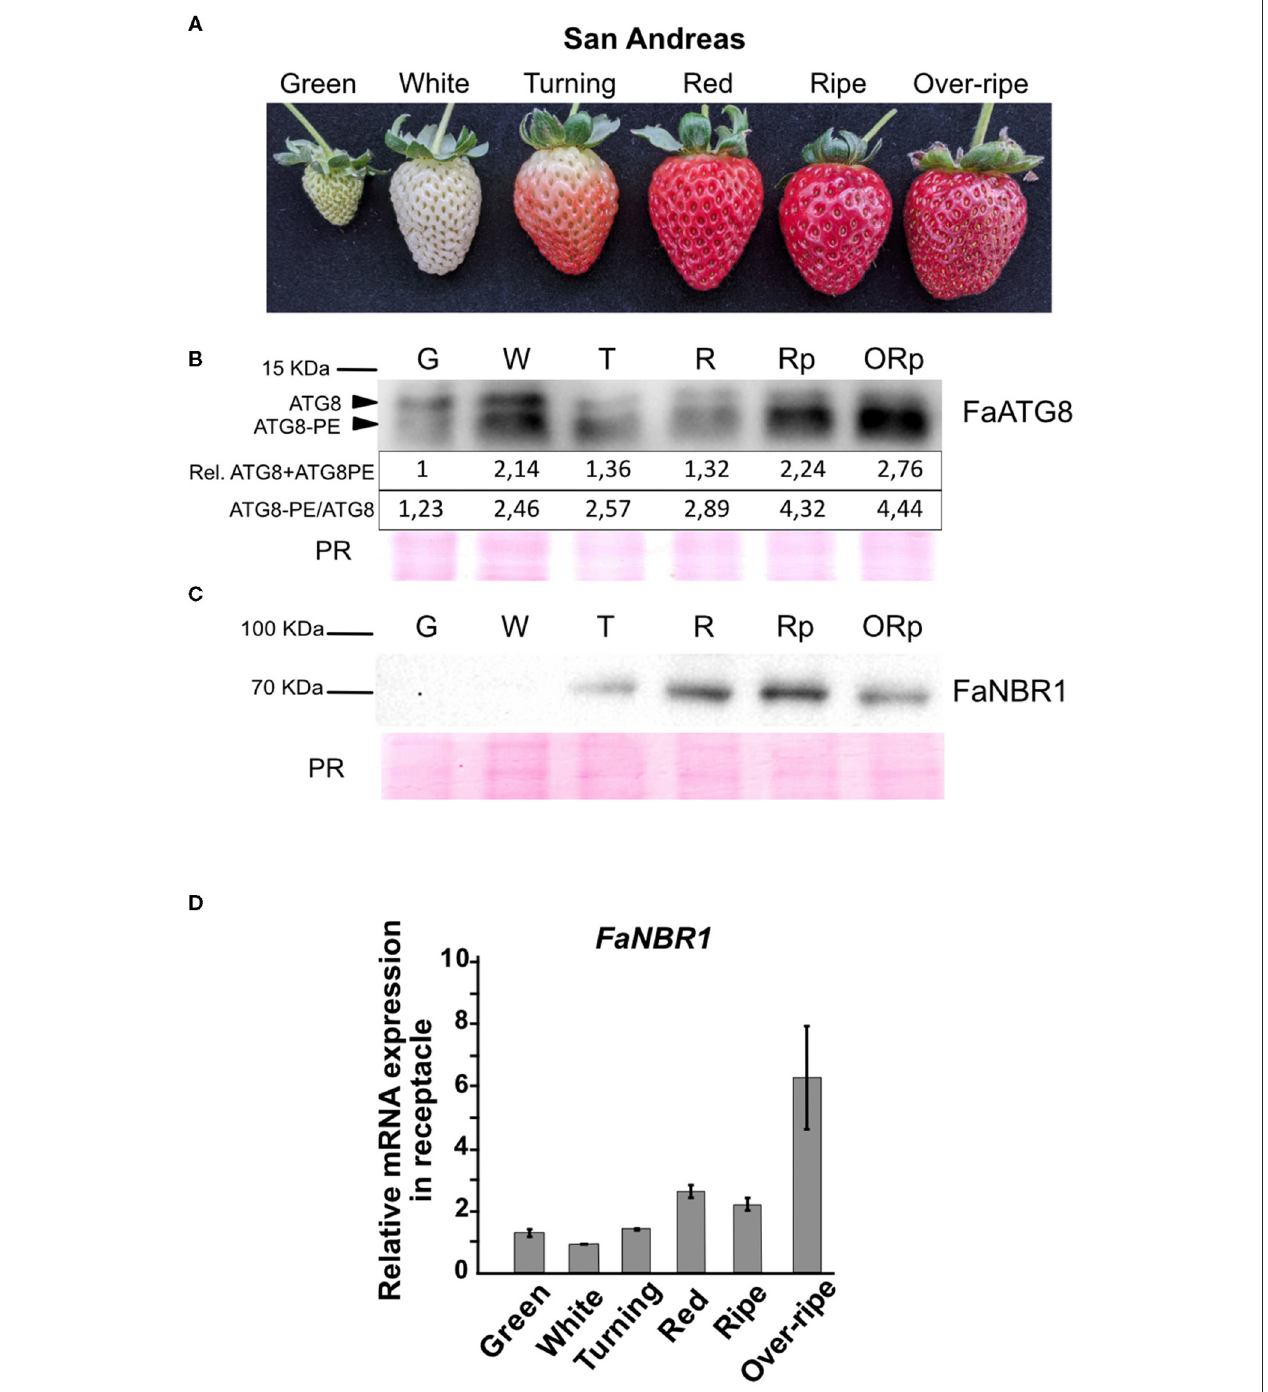
FIGURE 5 | Identification of two waves of autophagy flux along strawberry ripening. (A) Stages of strawberry ripening (cv. “San Andreas”) analyzed for autophagy flux. (B) Immunoblot of ATG8 showing non-lipidated (ATG8) and lipidated form (ATG8-PE) along ripening. Quantifications of band intensities are shown in arbitrary units. Rel. ATG8 + ATG8PE shows relative quantification of the summatory of ATG8 and ATG8PE signal. ATG8PE/ATG8 shows the ratio of both protein forms. (C) Immunoblot of NBR1 along ripening. (D) qRT-PCR analysis of FaNBR1 in F. x ananassa cv “San Andreas” along ripening. Error bars represent standard deviation. PR, Ponceau red.